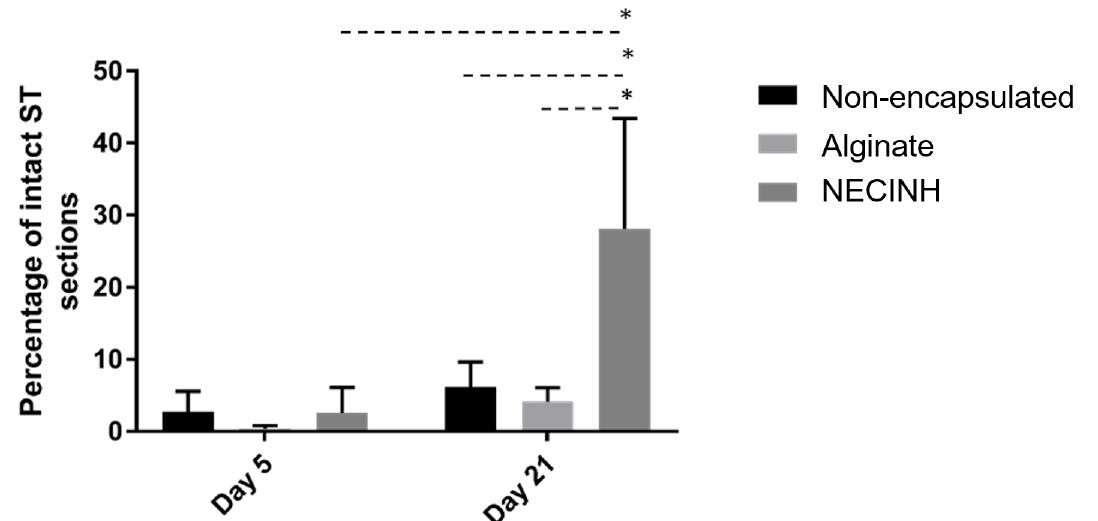
Figure 6. Impact of NECINH-nanoparticles-loaded hydrogel on mice testicular tissue after autotransplantation for 5 and 21 days. Tissue integrity evaluation on hematoxylin-eosin stained slides. The graph shows the percentage of intact (Score 1) STs (seminiferous tubule sections) evaluated at day 5 and day 21. * indicates p < 0.05 relative to day 21 Score 1 NECINH-NPs.